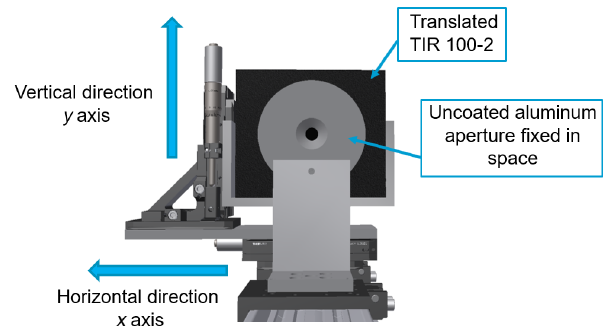
Figure 5. Direction of movement of the TIR 100-2 using the scanned aperture method. Front view.